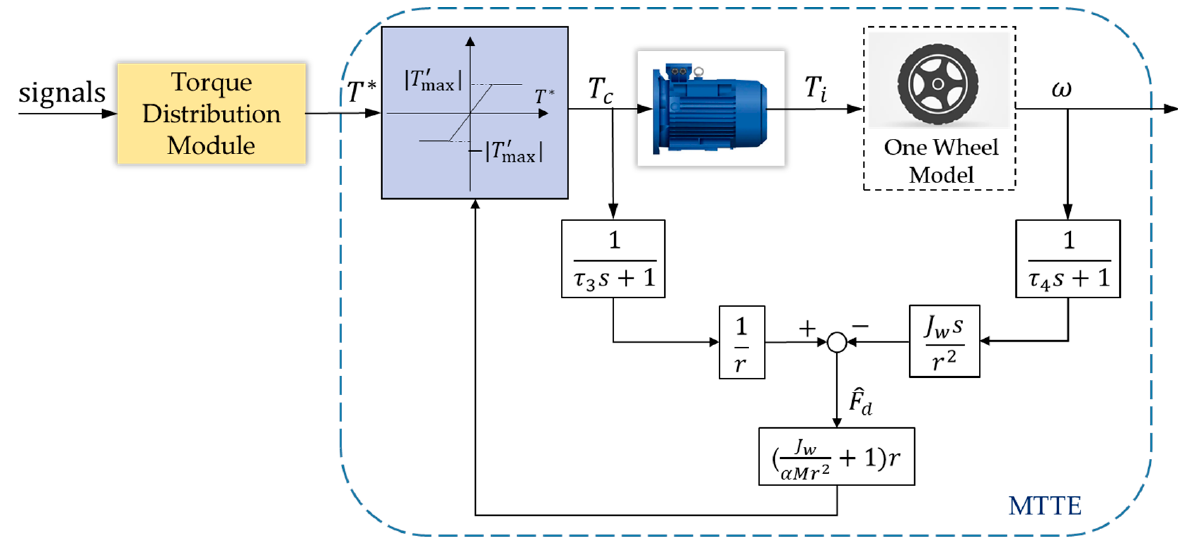
Figure 6. Control system based on MTTE.